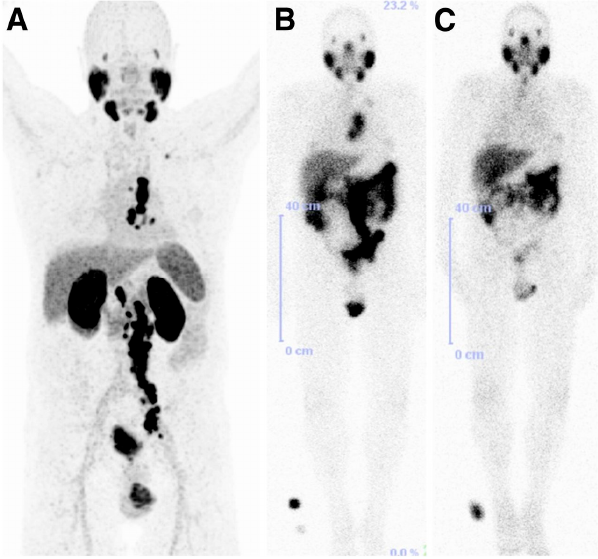
Figure 21. 70-year-old patient with PSMA-avid lymph node metastases on 68 Ga-PSMA PET/CT before therapy ( A ) and on 177 Lu-PSMA I&T scintigraphy after first PSMA radionuclide therapy ( B ); with remarkable reduction in uptake after second PSMA RLT ( C ). Results were consistent with excellent therapy response projection (Reprinted with permission of [153]).